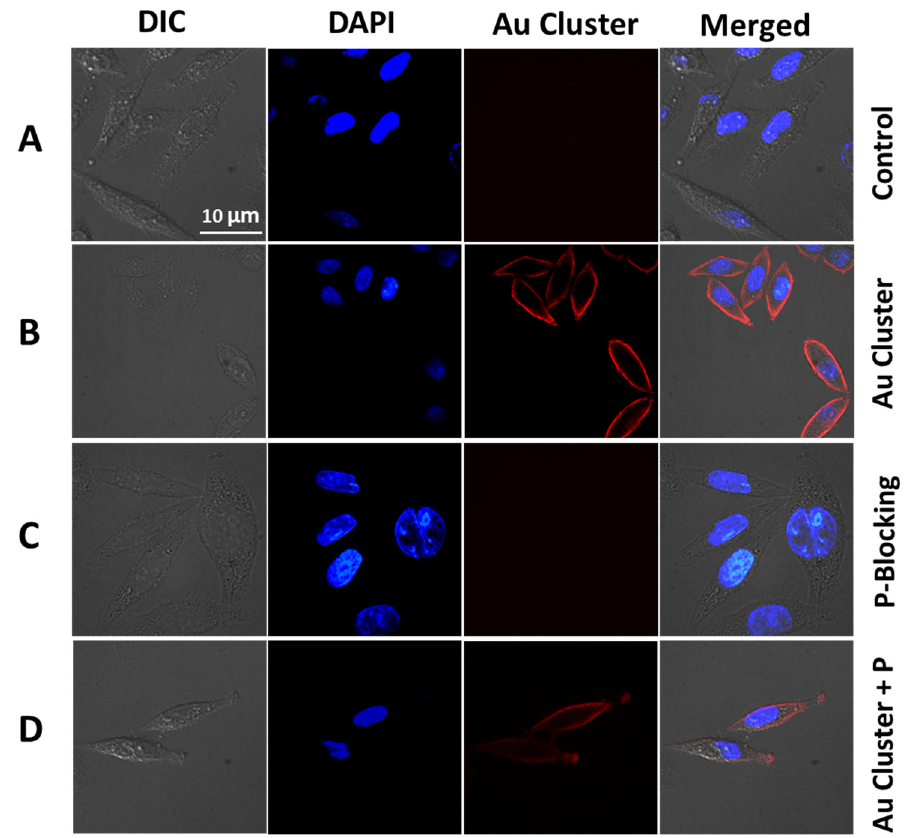
Figure 4. Au clusters specifically target MT1-MMP in cervical cancer Siha cells. ( A ) CLSM images of Siha cells treated with PBS. ( B ) Siha cells are marked by Au clusters (8 µ M for 30 min). ( C ) Siha cells were first treated with free peptides (2 mM for 1 h), followed by the addition of Au clusters (8 μ M for 30 min). ( D ) Free peptides (100 μ M) and Au clusters (8 μ M) were introduced to Siha cells at the same time and incubated for 30 min. The blue fluorescence is the DAPI for the cell nuclei.